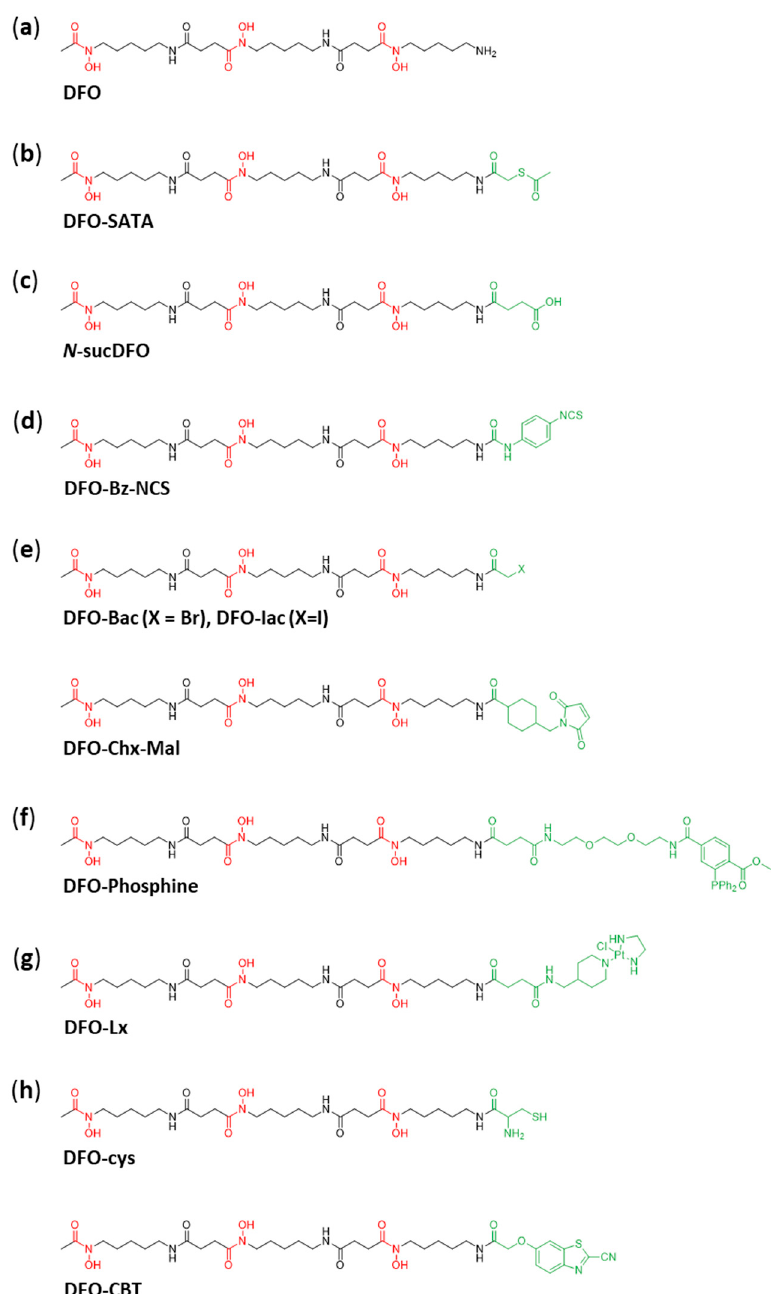
Figure 3. DFO and its bifunctional variants with the bifunctional moieties highlighted in green. ( a ) The chelator desferrioxamine (DFO) without bifunctionalization. ( b ) The first bifunctional variant of DFO, N -( S -acetyl)mercaptoacetyldesferal (DFO-SATA). ( c ) N -sucDFO was the first bifunctionalized DFO-chelator, that was used widely for 89 Zr-radiolabeling of mAbs. ( d ) DFO-Bz-NCS allows the radiolabeling of mAbs in only two steps. ( e ) Three thiol reactive chelators; DFO-Bac, DFO-Iac and DFO-Chx-Mal. ( f ) DFO-Phosphine was developed for a pretargeting approach. ( g ) DFO-Lx is a bifunctionalized DFO variant using a platinum(II) linker. ( h ) For mAb-conjugation via click reaction through a luciferin-mediated approach DFO-cys and DFO-CBT were developed.